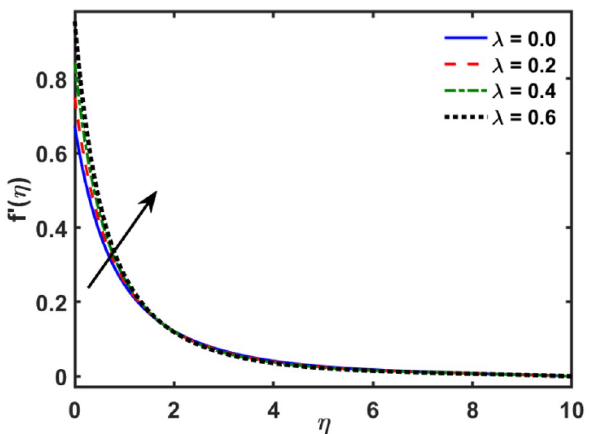
Figure 3. Variation of (cid:31) on f ′ (η)